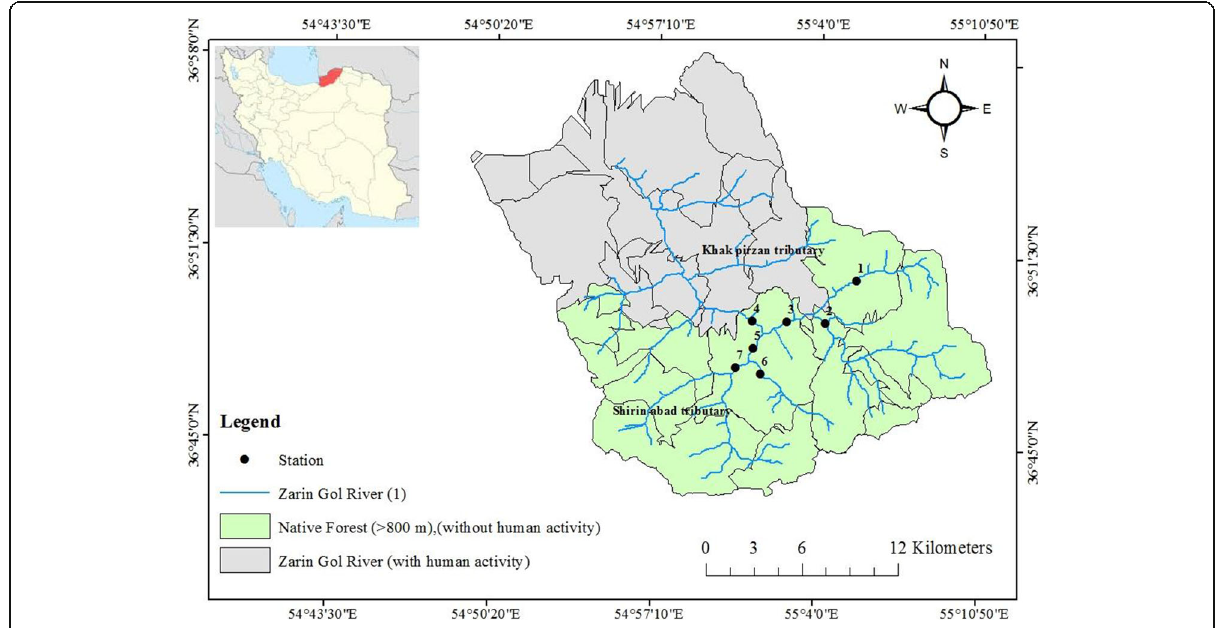
Fig. 1 Map of the study area, displaying the location of the study sites in Zarin Gol River,